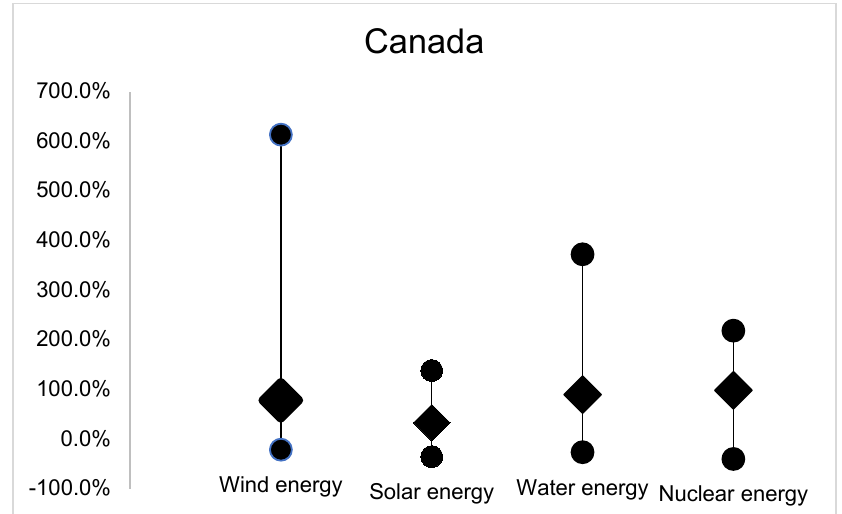
Figure 12. Willingness to pay for various types of electric energy in Canada . Source: own study.